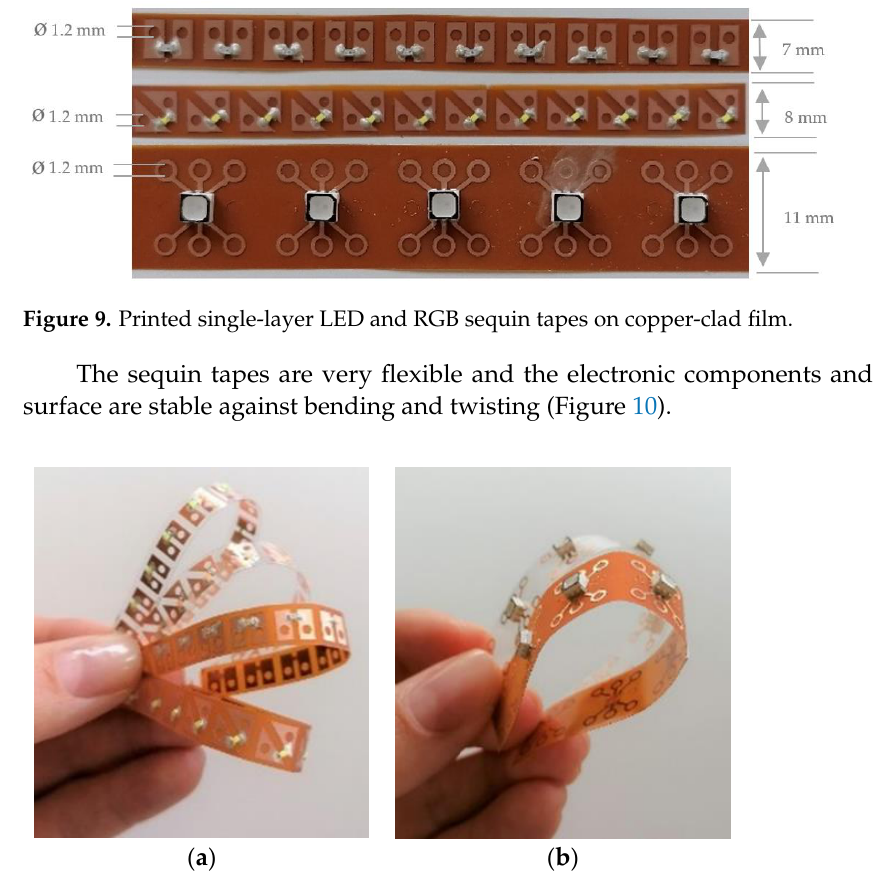
Figure 8. Printed single-layer LED and RGB sequin tapes on PET film with copper adhesive tape.